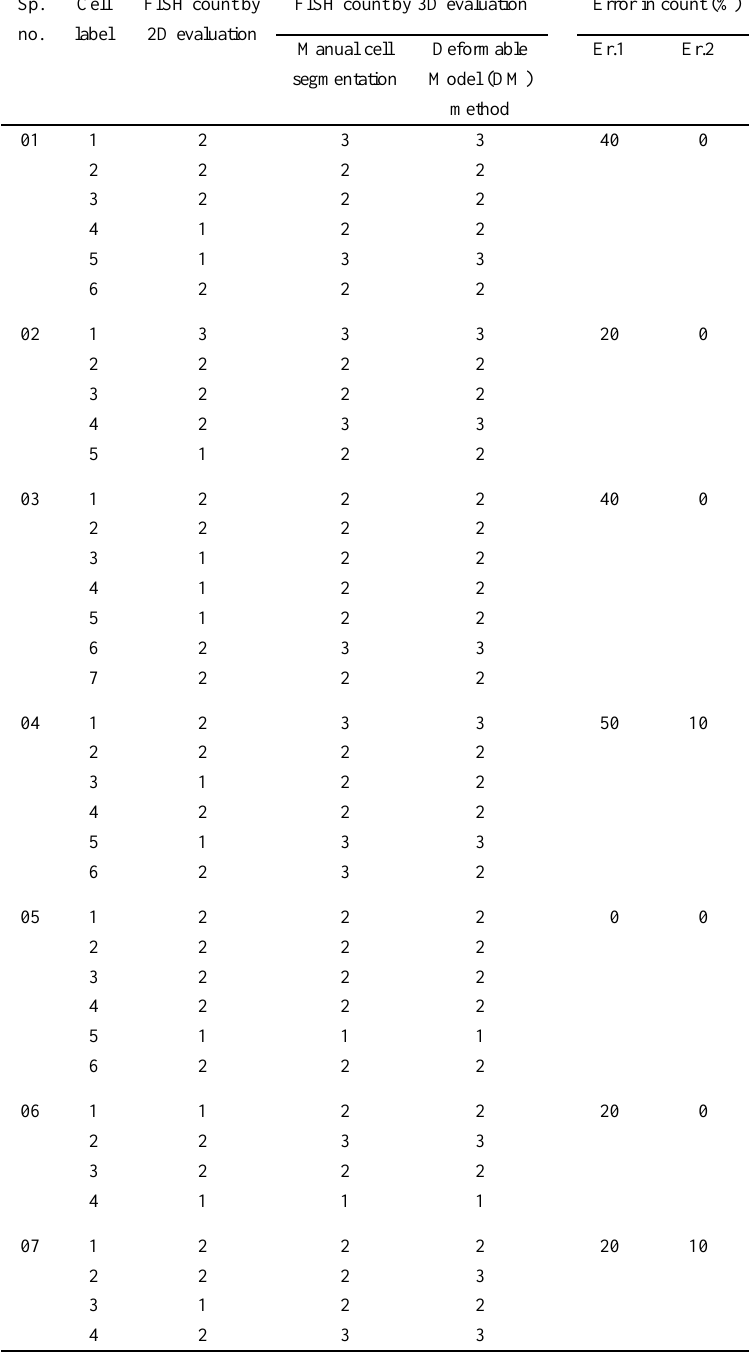
Comparative analysis of FISH signal counting based on different cell segmentation approaches Sp. Cell FISH count by FISH count by 3D evaluation Error in count (%) no. label 2D evaluation Manual cell